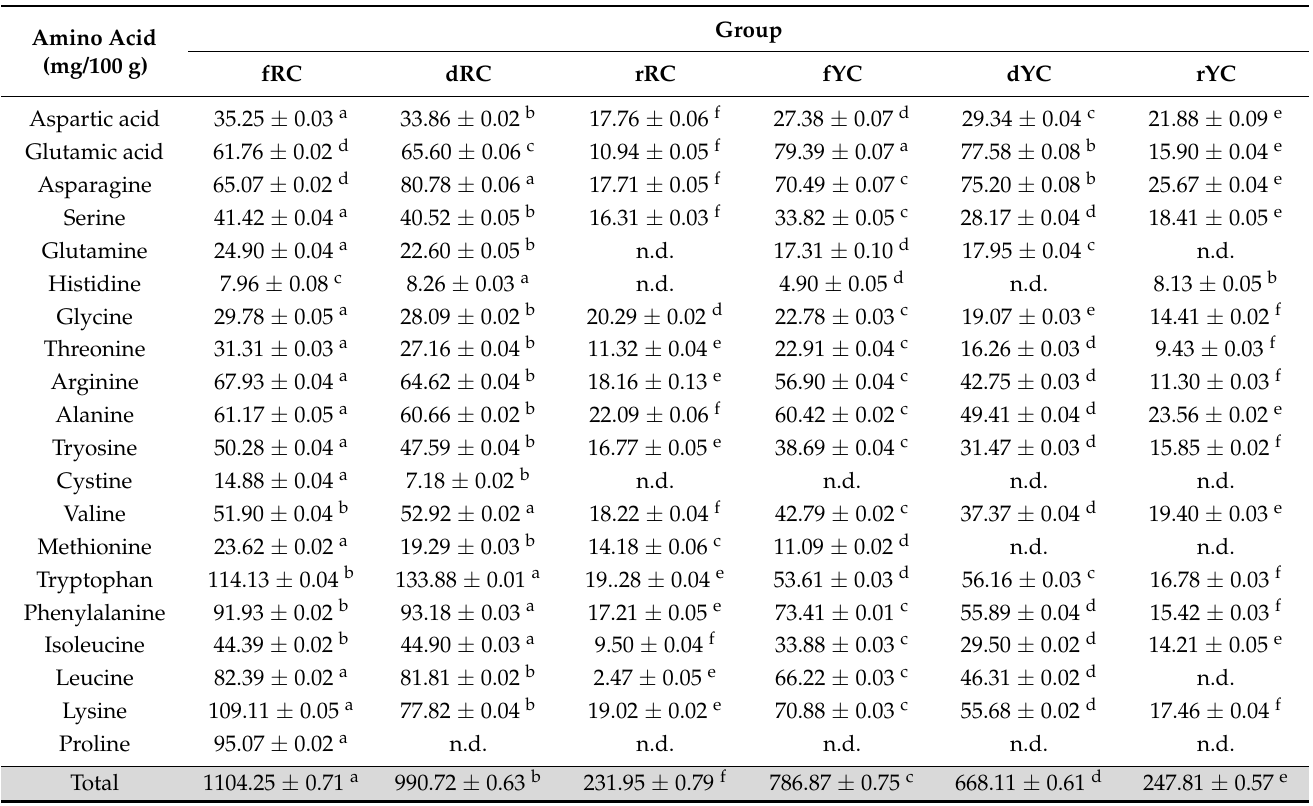
Table 6. Variation of amino acid pattern in differently treated polymorphic cacao beans *.